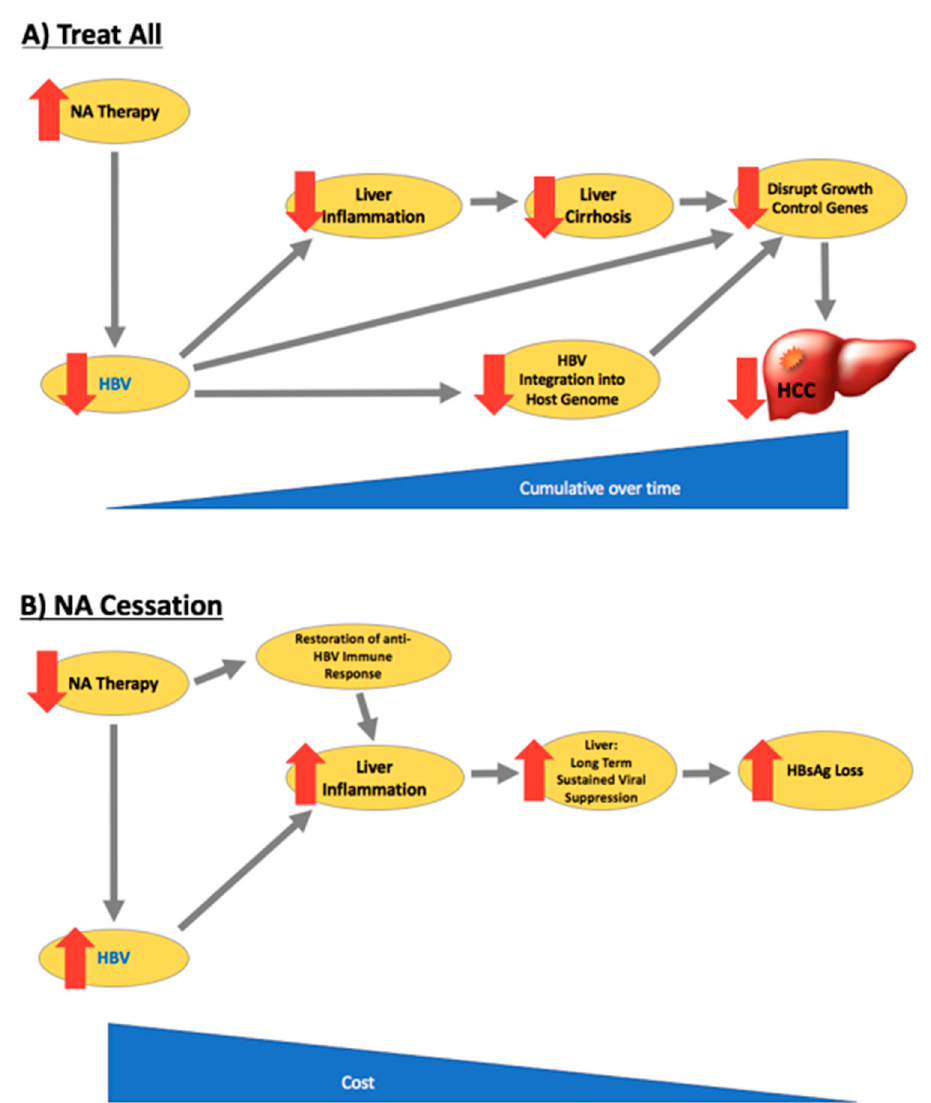
Figure 1. Benefits of “treat all” and nucleos(t)ide analogue (NA) cessation: HBsAg loss rates and hepatocellular carcinoma (HCC)/cirrhosis risk. ( A ) “Treat all” reduces HBV viraemia, hepatic inflammation, and thus cirrhosis and HCC risk; ( B ) “NA cessation” causes an initial HBV viral relapse with subsequent increase in rates of HBsAg loss.